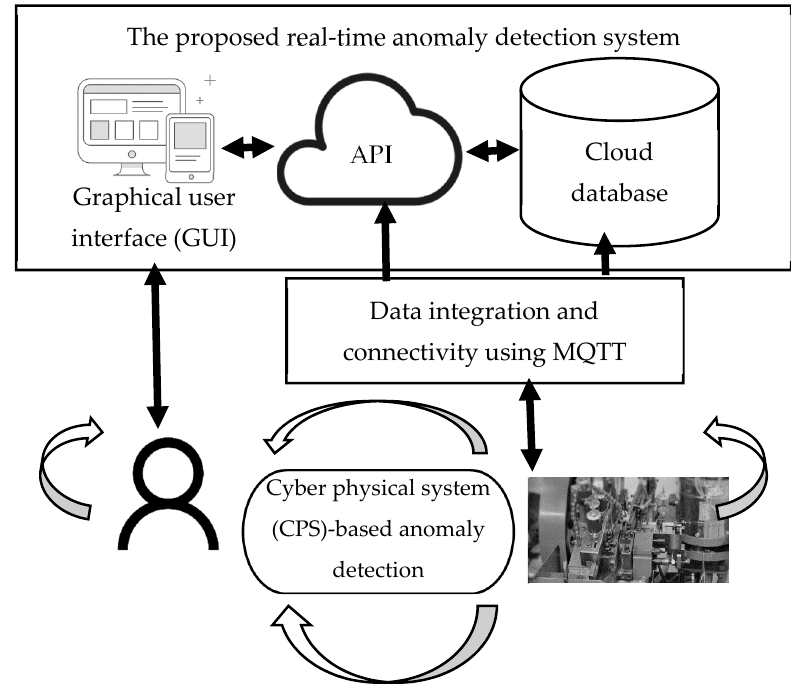
Figure 8. Architecture of the proposed real-time anomaly detection system.